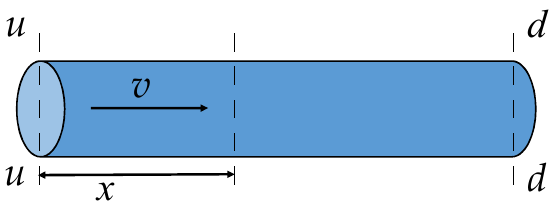
Figure 3. Single characteristic computing